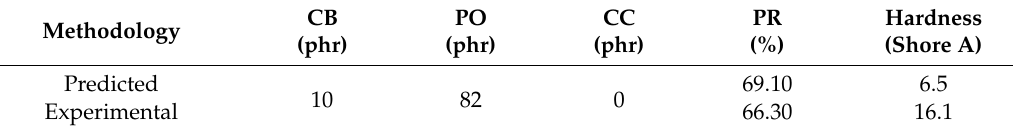
Table 4. Experimental and predicted optimal compositions of vulcanized NRs properties.